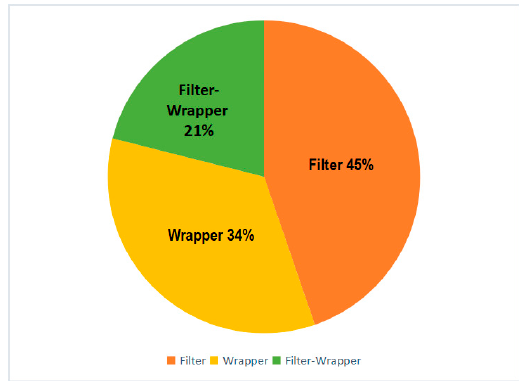
Figure 4. Distribution graph of the Filter and Wrapper approach in our literature survey.